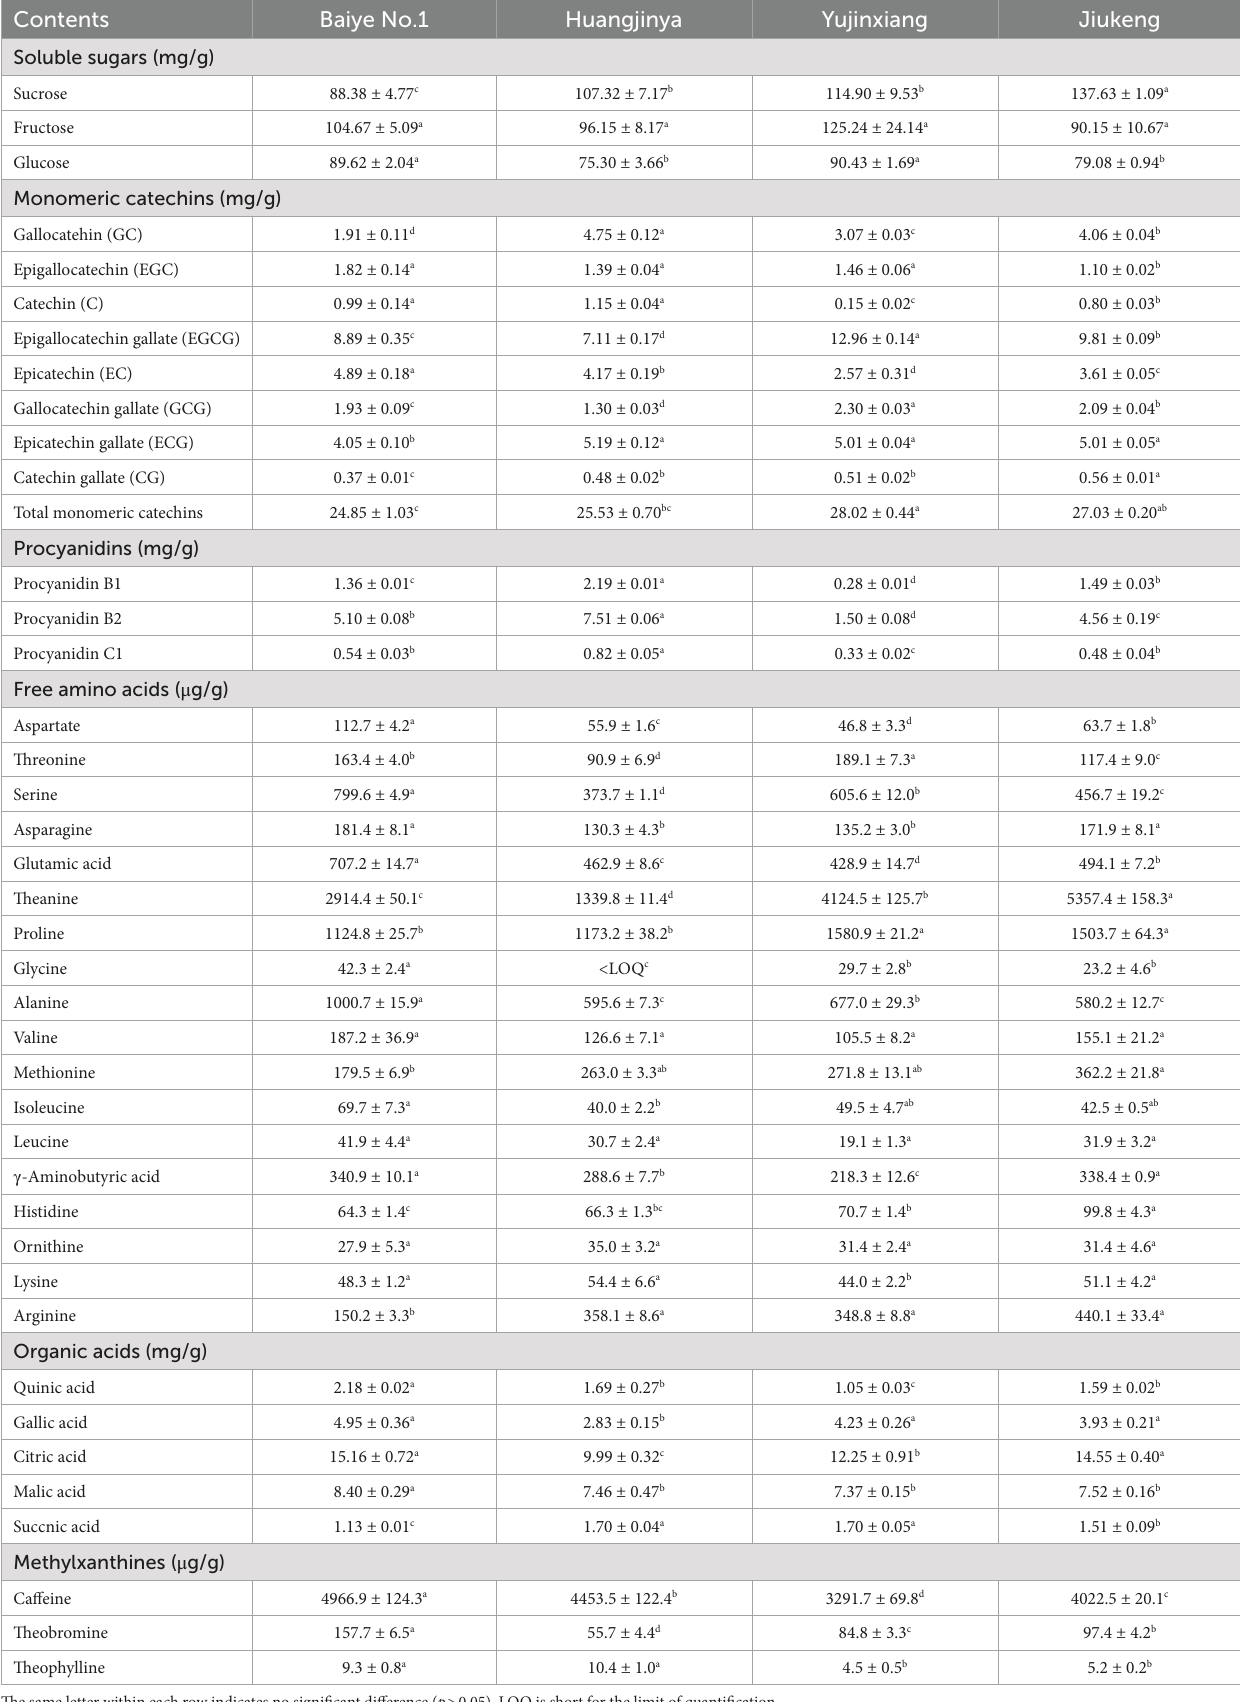
TABLE 2 The contents of soluble sugars, monomeric catechins, procyanidins, free amino acids, organic acids, and methylxanthines in four tea